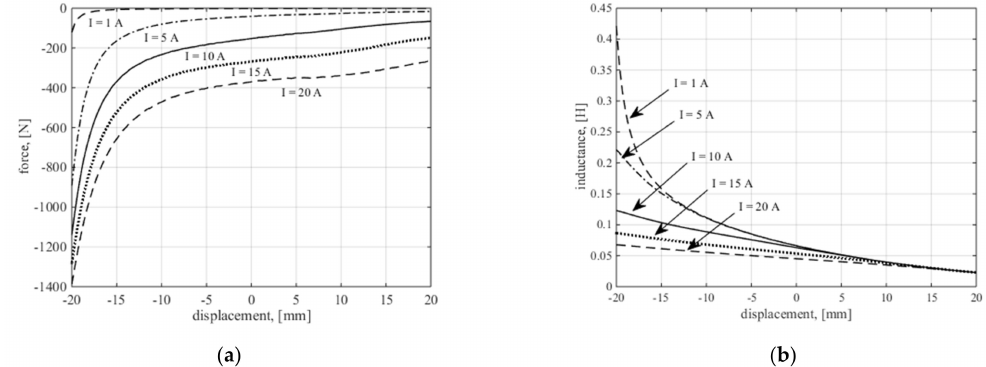
Figure 9. Family characteristics of ( a ) the magnetic force acting on the piston and ( b ) the inductance of the coil vs. motor piston displacement calculated for different currents.